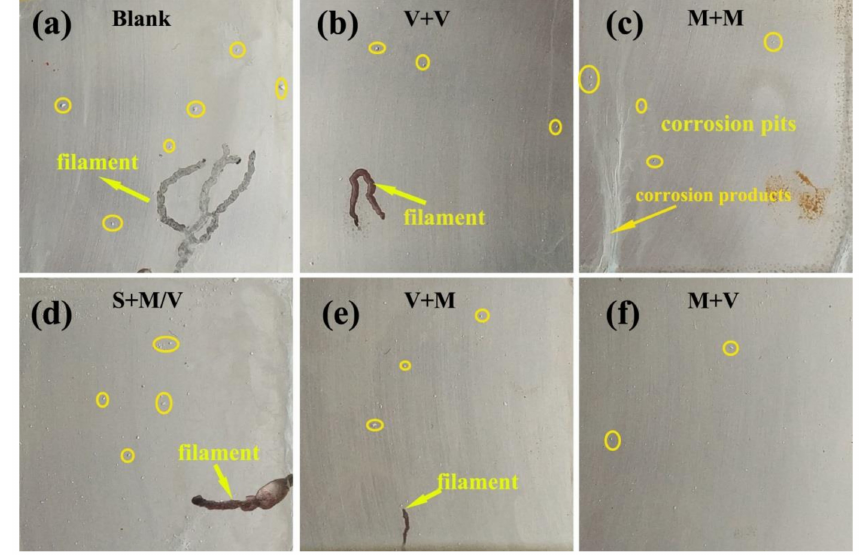
Figure 8. Optical photographs of AA2024 coated with ( a ) Blank coating, ( b ) V + V coating, ( c ) M + M coating, ( d ) S + M/V coating, ( e ) V + M coating, and ( f ) M + V coating after 840 h of exposure to salt spray